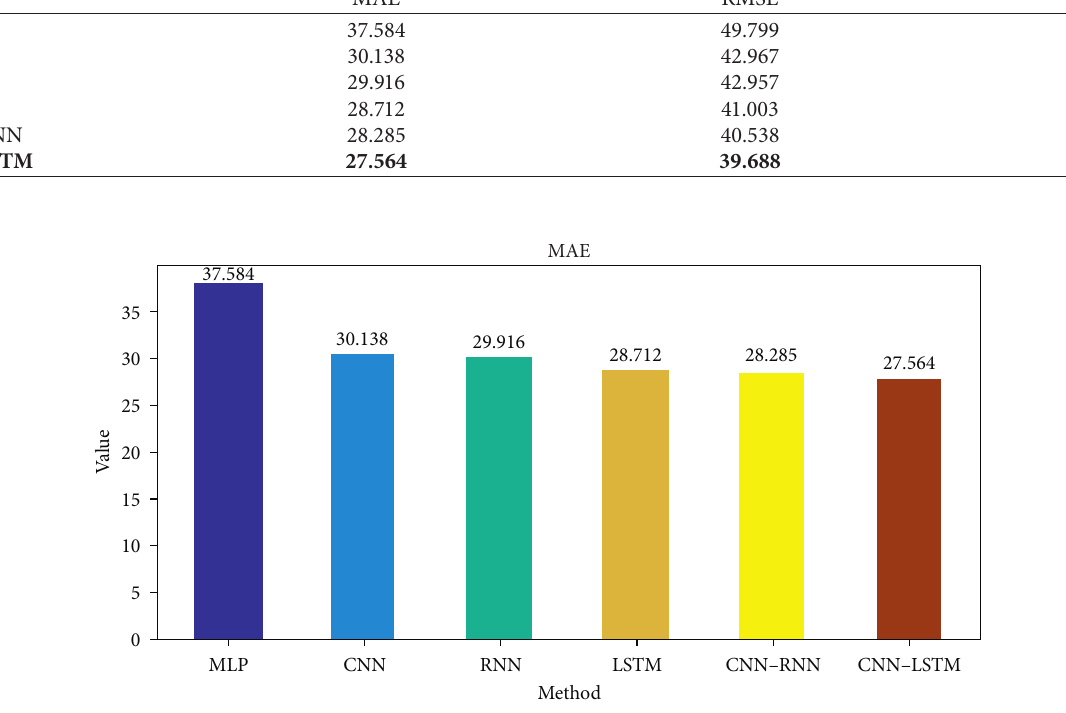
Figure 11: The result of MAE comparison among different